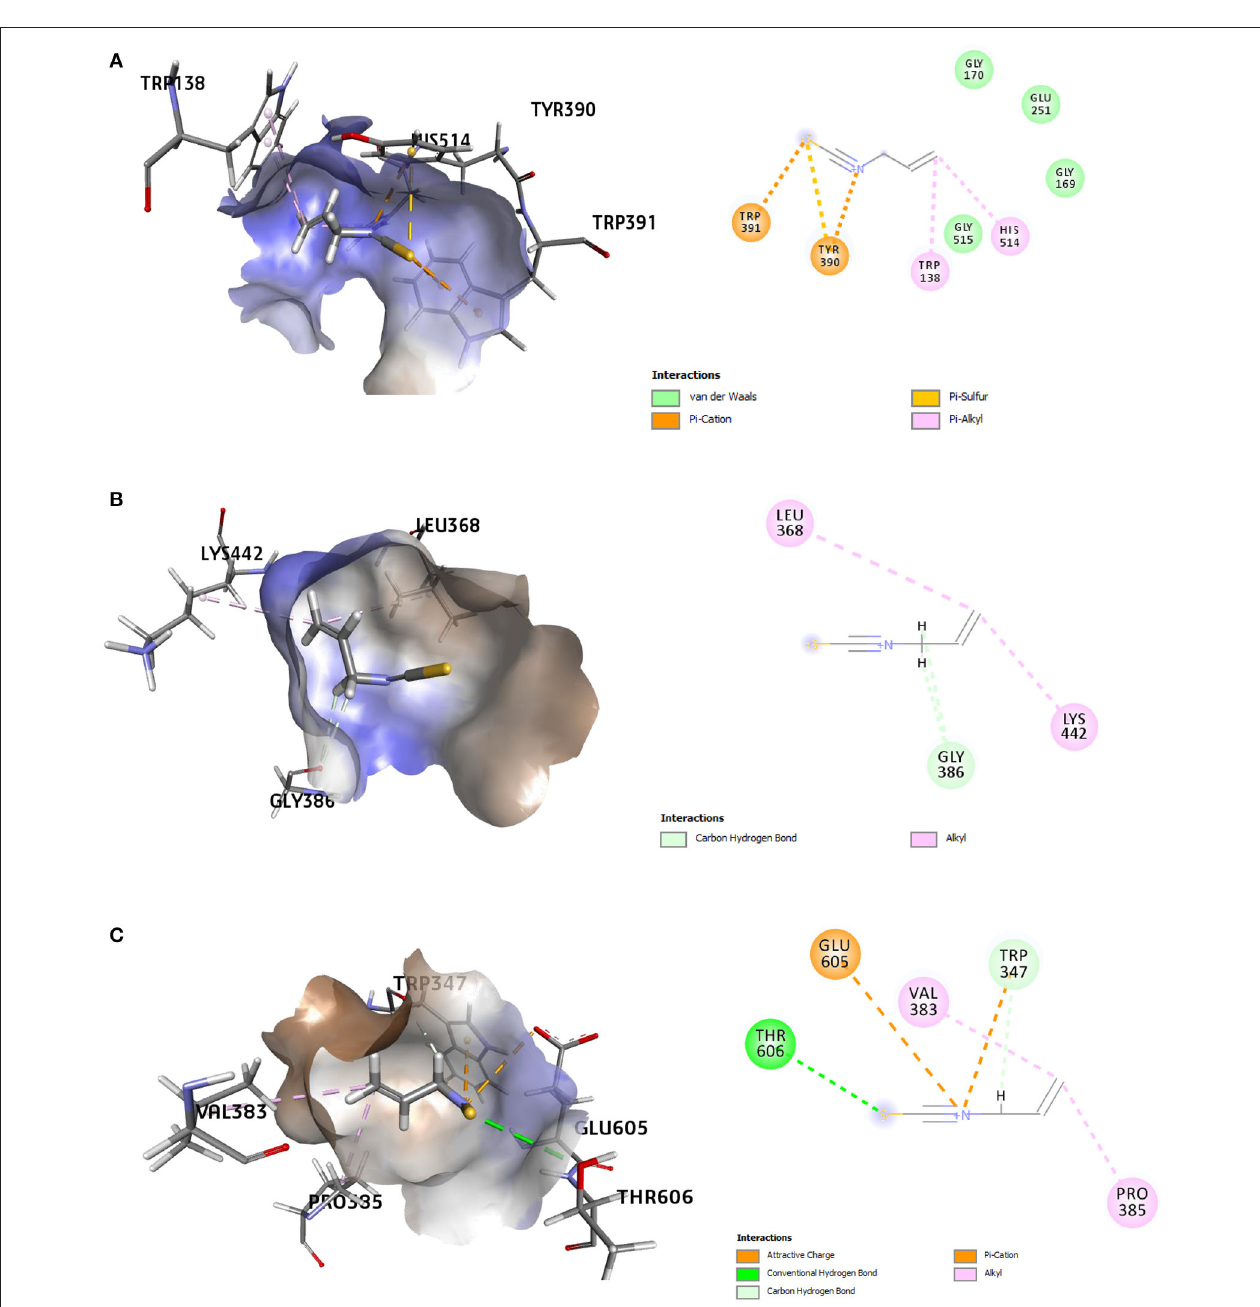
FIGURE 8 | 3D and 2D representations of the AITC-bound target sites of (A) acetyl cholinesterase (AChE), (B) neuropeptide (G-protein coupled receptor) GPCR, and (C) odorant response gene-1 (ODR1).